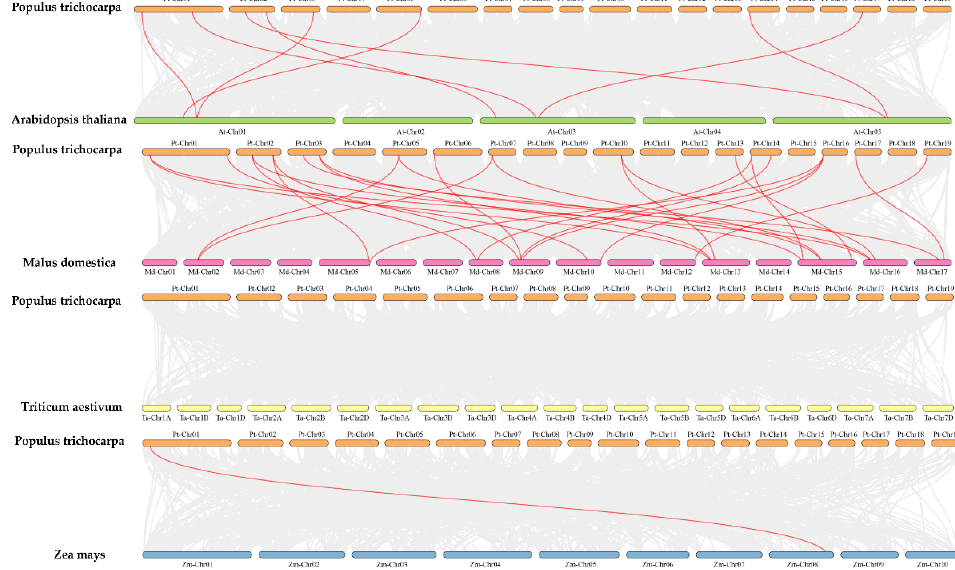
Figure 5. Collinear analysis of poplar PtrFBAs gene family with 4 typical plants ( Arabidopsis , wheat, maize and apple). Gray lines in the background represent collinear blocks of P. trichocarpa and other species genomes, while red lines emphasize collinear PtrFBAs gene pairs.